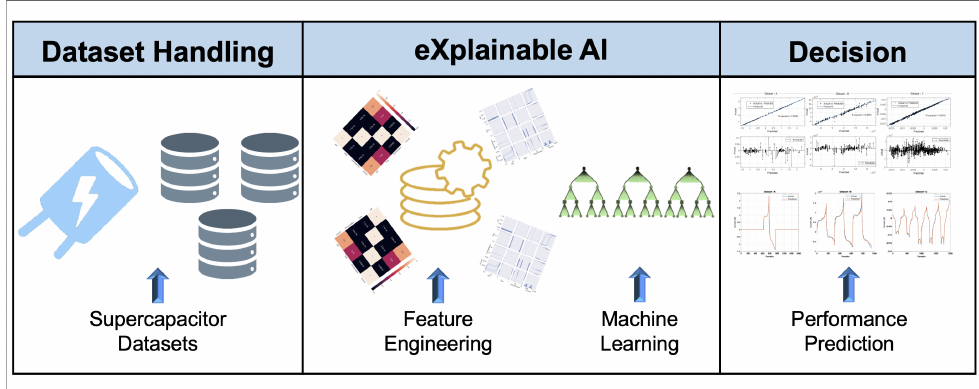
Figure 1. General framework of the proposed